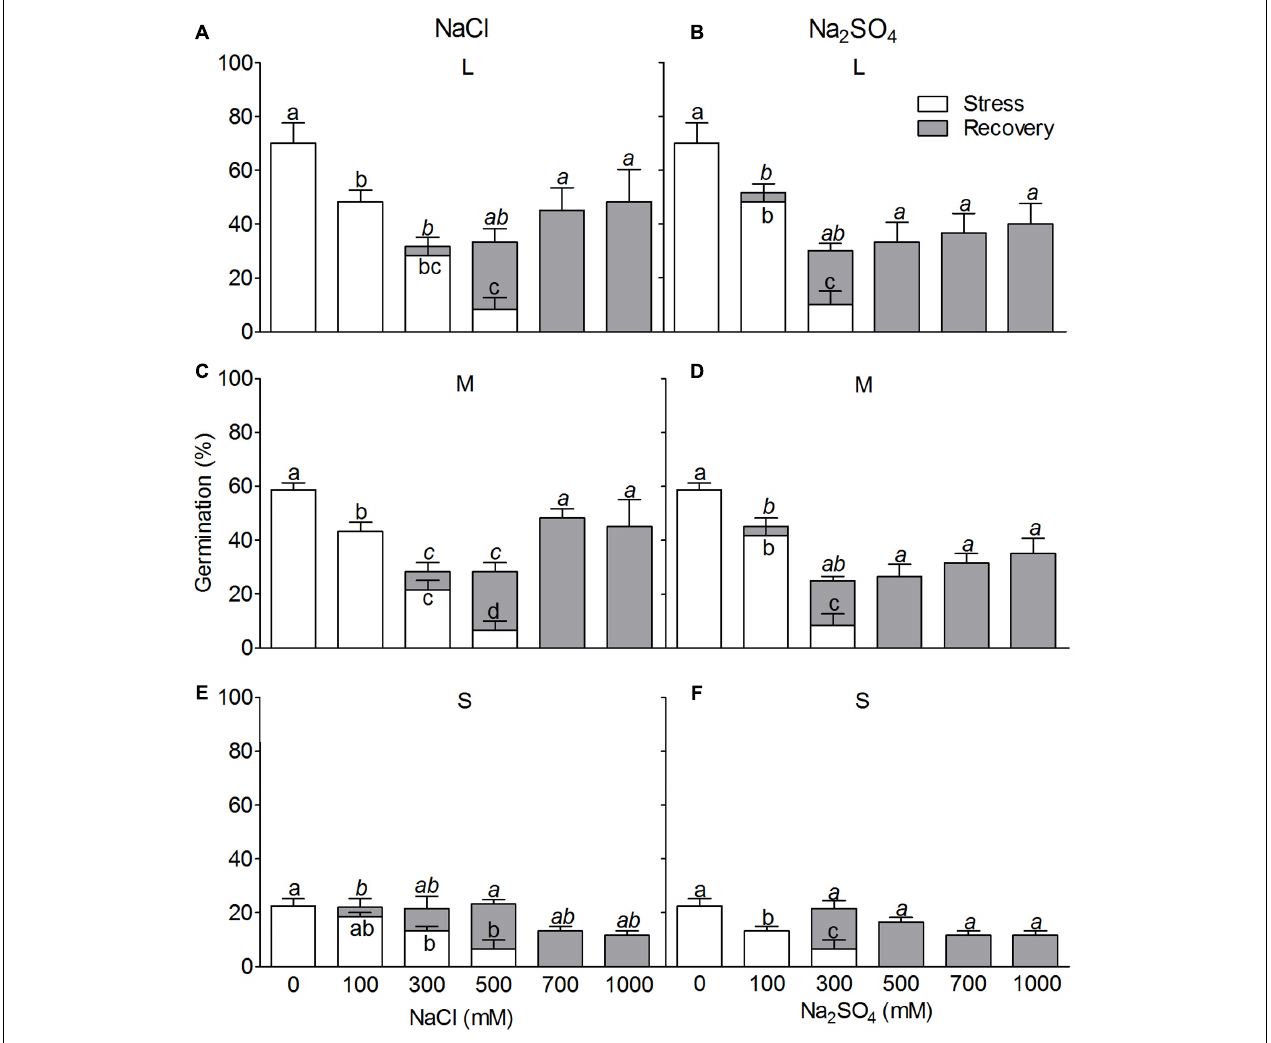
FIGURE 12 | Effect of different salt types on germination of S. ferganica heteromorphic seeds. (A–C) NaCl treatment; (D–F) Na 2 SO 4 treatment. (A,D) Large seed; (B,E) middle seed; (C,F) small seed. L, M, S, large, middle, small seed. Stress: salt treatment. Recovery: ungerminated seeds under salt treatment transferred into distilled water. Bars with different lowercase letters indicate significant differences ( P < 0.05) according to the Tukey’s test. Values are means ± SE of four replicates.